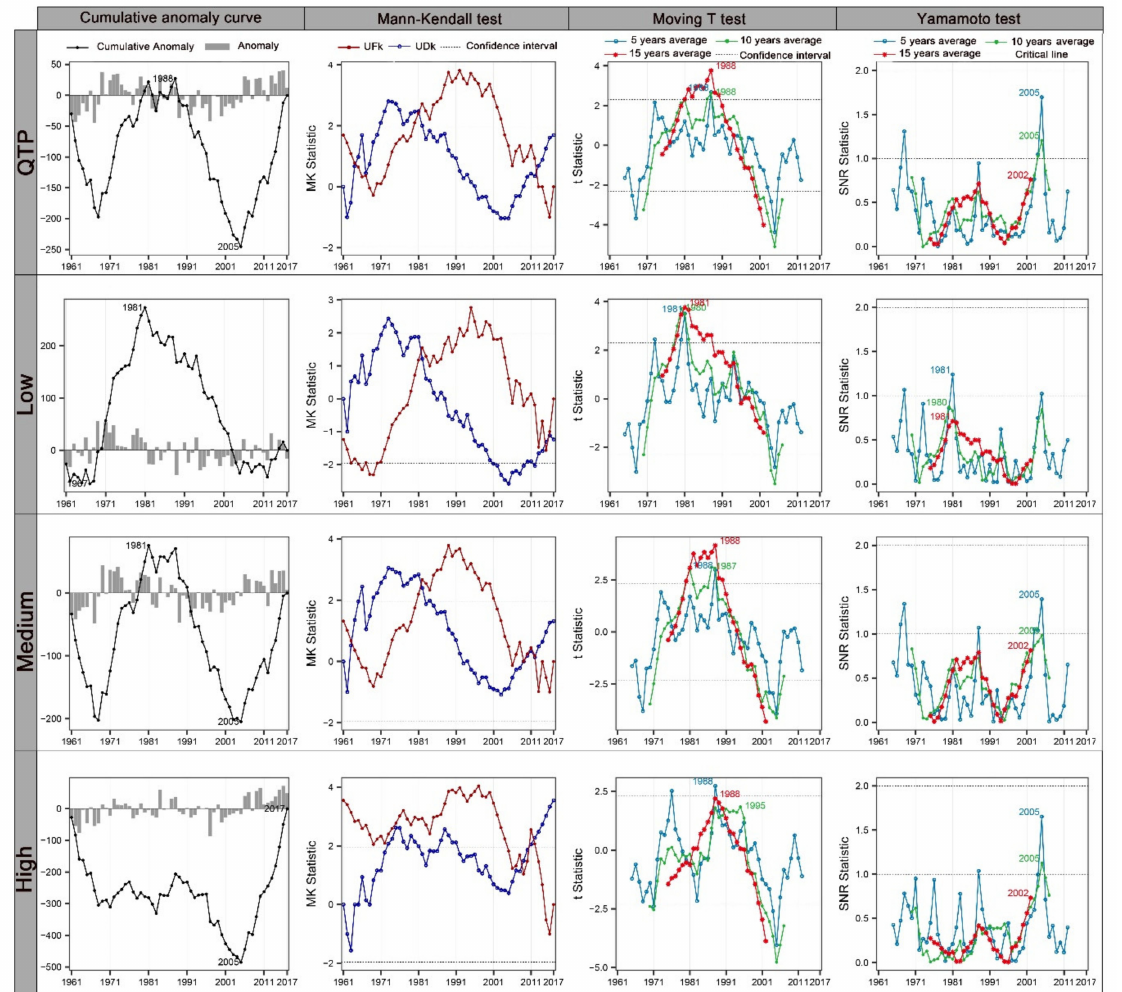
Figure 5. The results of mutation analysis of annual ET 0 on different elevation zones. The marked year of the cumulative anomaly curve is the year in which positive and negative peaks occur. The marks in the moving t-test and Yamamoto test are the years in which the peak value of each line